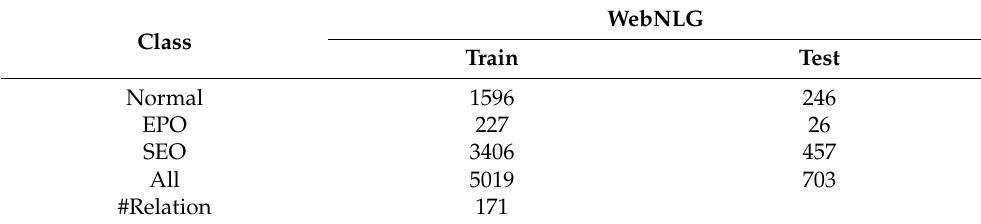
Table 1. Statistics of the WebNLG dataset.